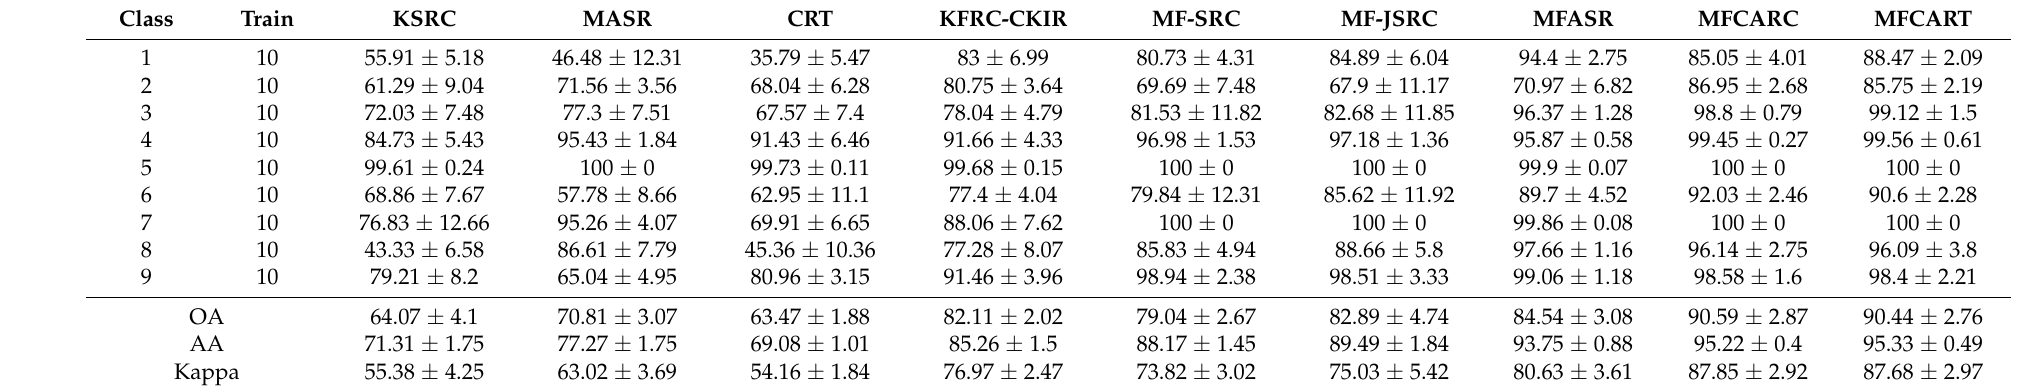
Table 8. Classification accuracy (%) of different classifiers for the University of Pavia data set.